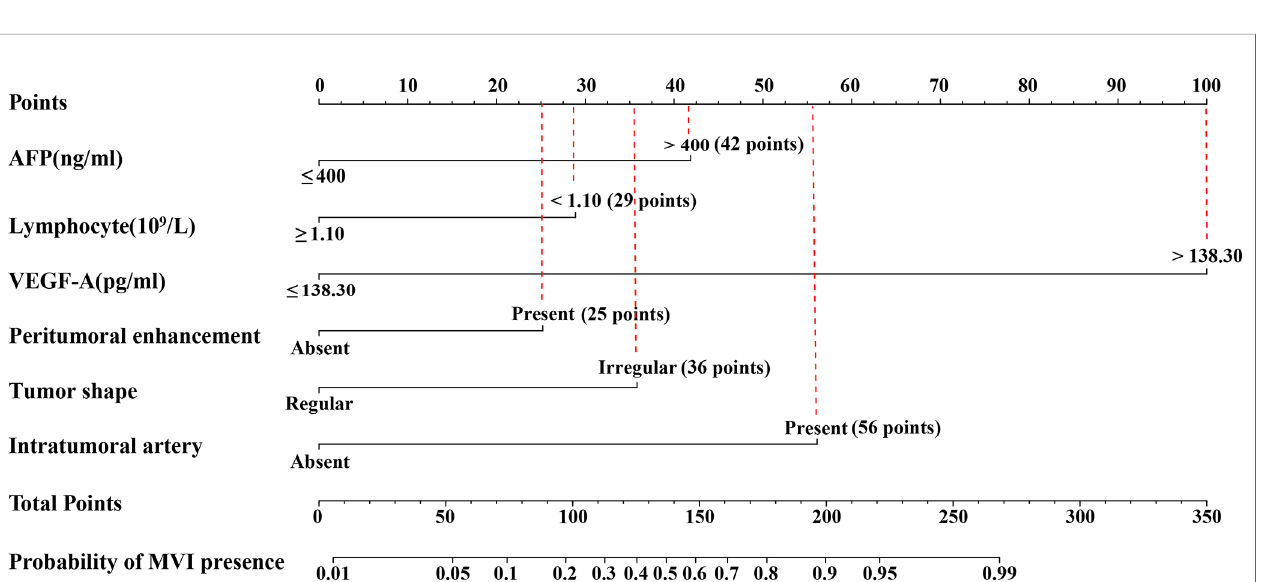
FIGURE 5 | Nomogram to predicting MVI. The use of nomogram was as follows: Points are assigned for each variable by drawing a straight line upward from the corresponding value to the “ Points ” line. Then, sum the points received for each variable, and locate the number on the “ Total Points ” axis. To speculate the patient ’ s MVI status, a straight line must be drawn down to the corresponding “ MVI presence ” probability axis. AFP, alpha fetoprotein; VEGF-A, Vascular endothelial growth factor A; MVI, microvascular invasion.